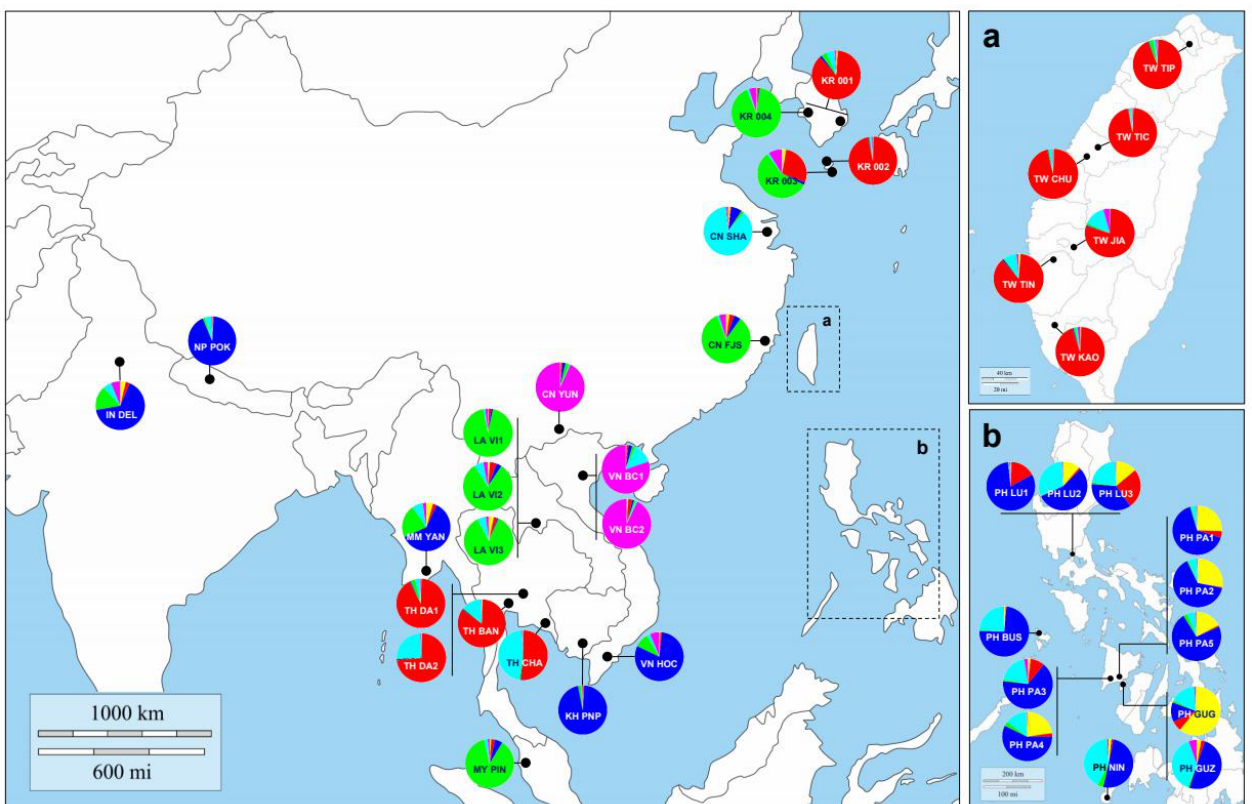
Figure 4. Bayesian clustering results (STRUCTURE for K = 6) in combination with the geographic locations of population collections. Each color means the independent assignment estimated by STRUCTURE. Dotted rectangles expand to ( a ) the Taiwan region and to ( b ) the Philippines region. KR, Korea; TW, Taiwan; CN, China; VN, Vietnam; LA, Laos; MM, Myanmar; TH, Thailand; KH, Cambodia; IN, India; NP, Nepal; PH, the Philippines; MY, Malaysia.